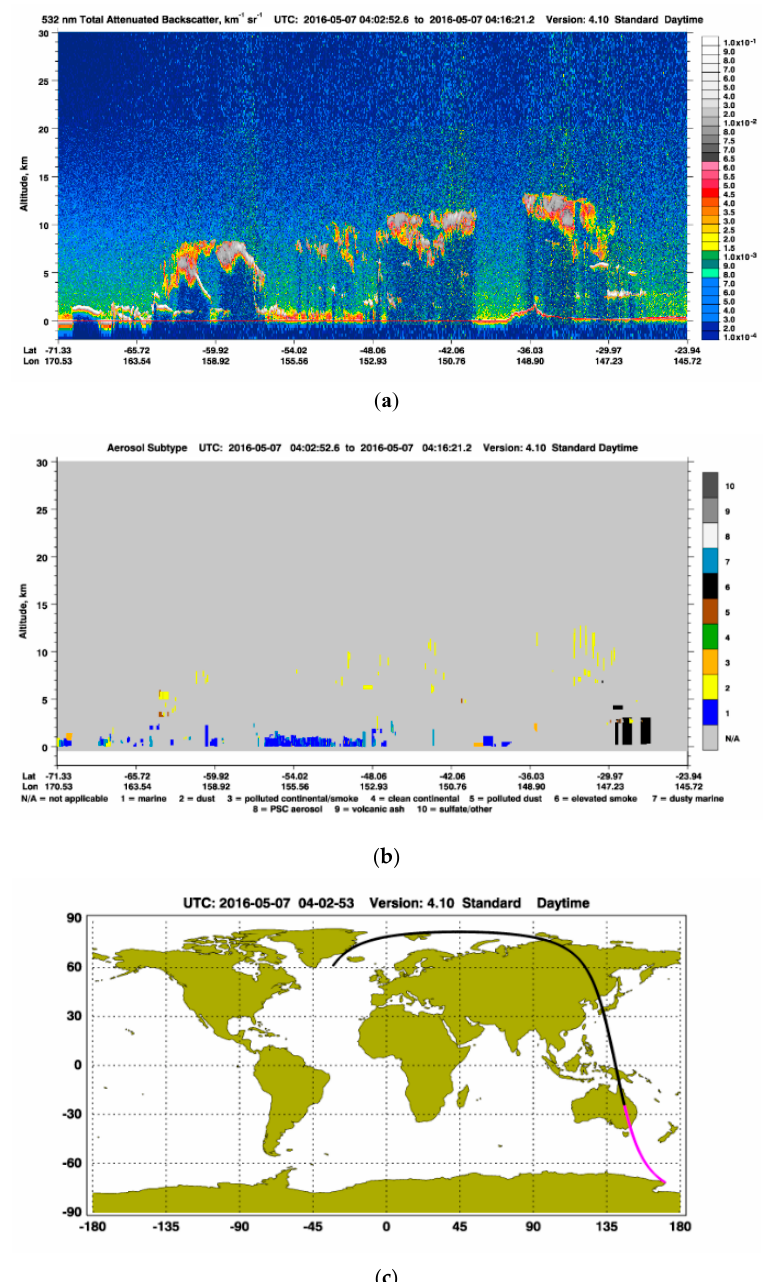
Figure 18. ( a ) Aerosols measured by CALIOP in the daytime transect from ( − 71.33, 170.53) to ( − 23.94, 145.72) on 7 May 2016 532 nm total attenuated backscatter; ( b ) profile of aerosol subtypes